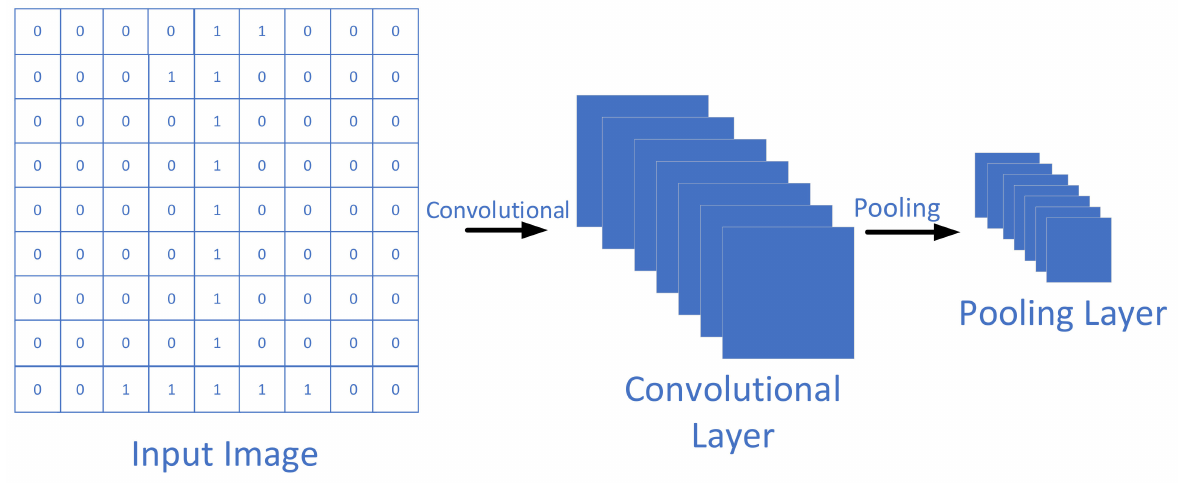
Figure 9. The architecture of the max-pooling layer.